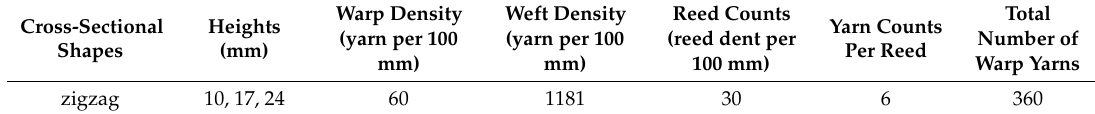
Table 1. Parameters of the zigzag-shaped 3D fabrics with three different heights.